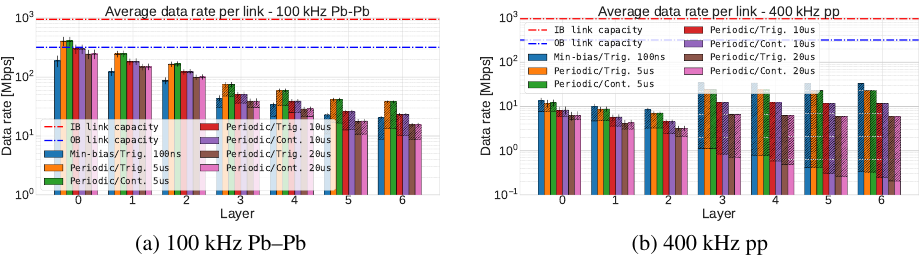
Figure 4: Average data rate per link. Note: y-axis range di ff ers between the plots.